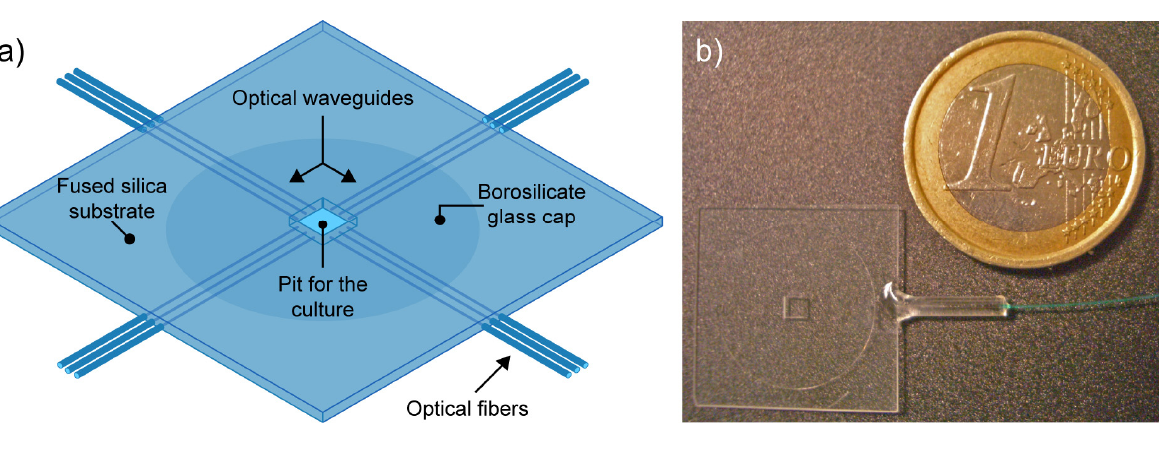
Figure 1. (a) Rationale of the chip for optical uncaging. Several optical waveguides drive excitation light in to the cell culture region (central well). The culture will take place on a thin glass, allowing high quality optical imaging from the bottom . (b) Top view of the fabricated chip. One of the waveguides was bonded to an optical